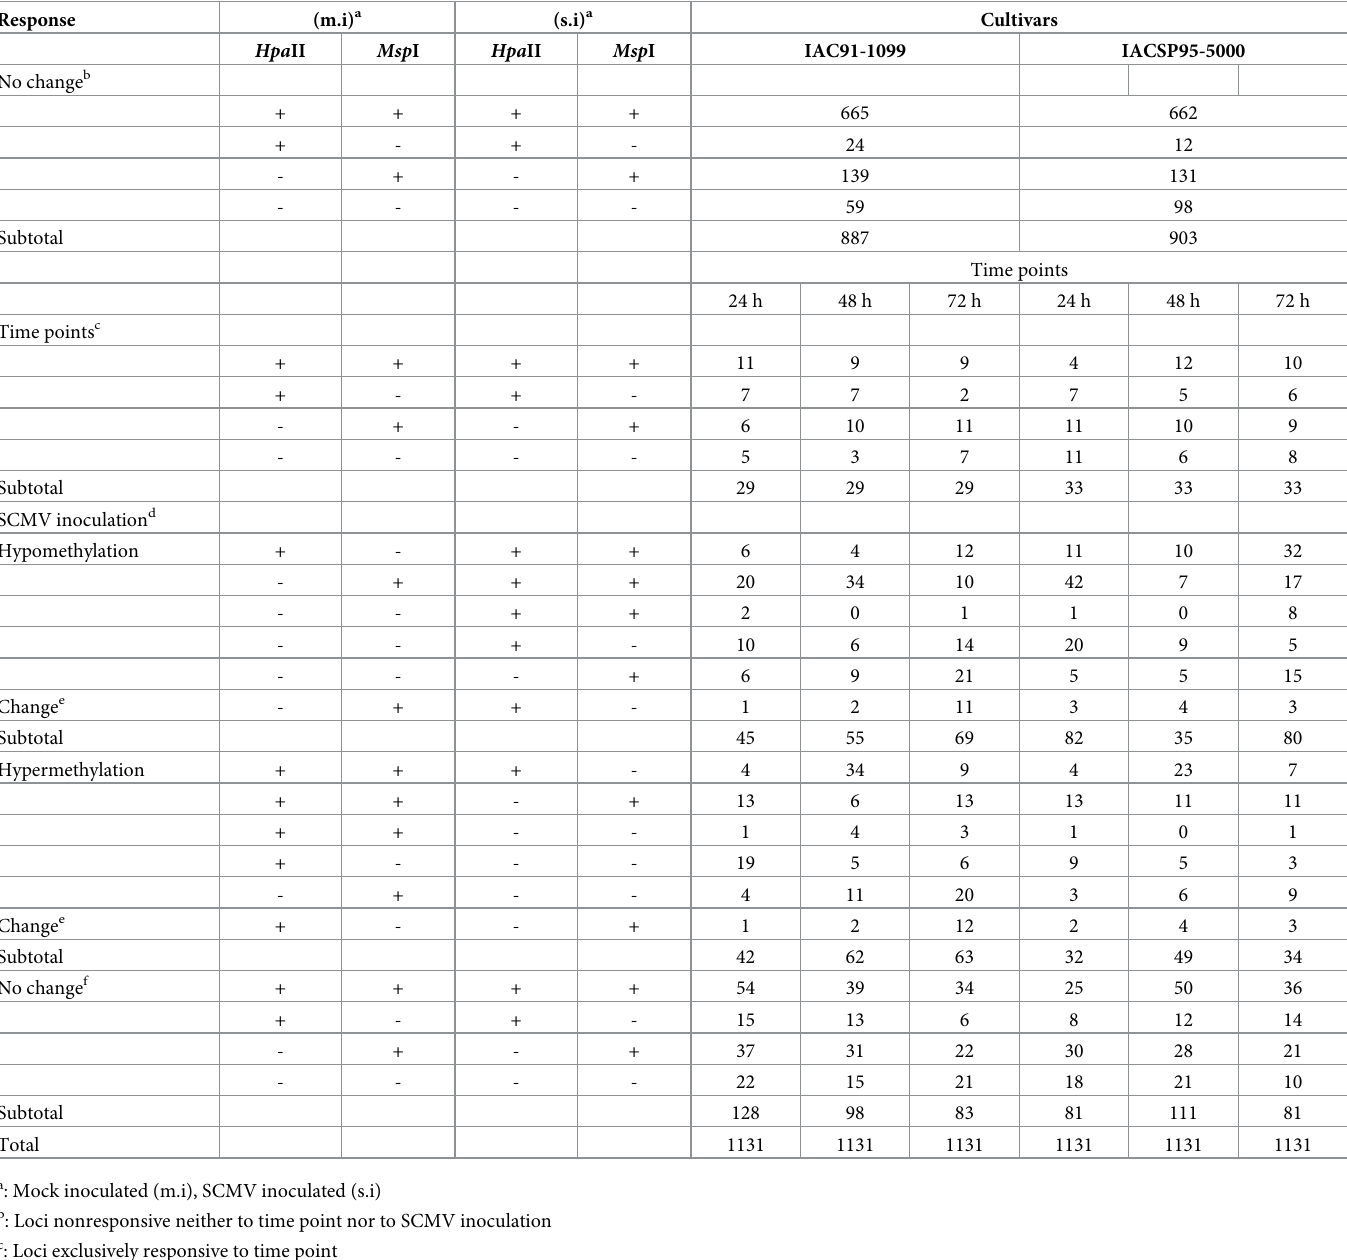
Table 2. Frequency of MSAP patterns and changes under SCMV infection and time points for the cultivars IAC91-1099 and IACSP95-5000. (+) and ( − ) represent presence and absence of bands, respectively.